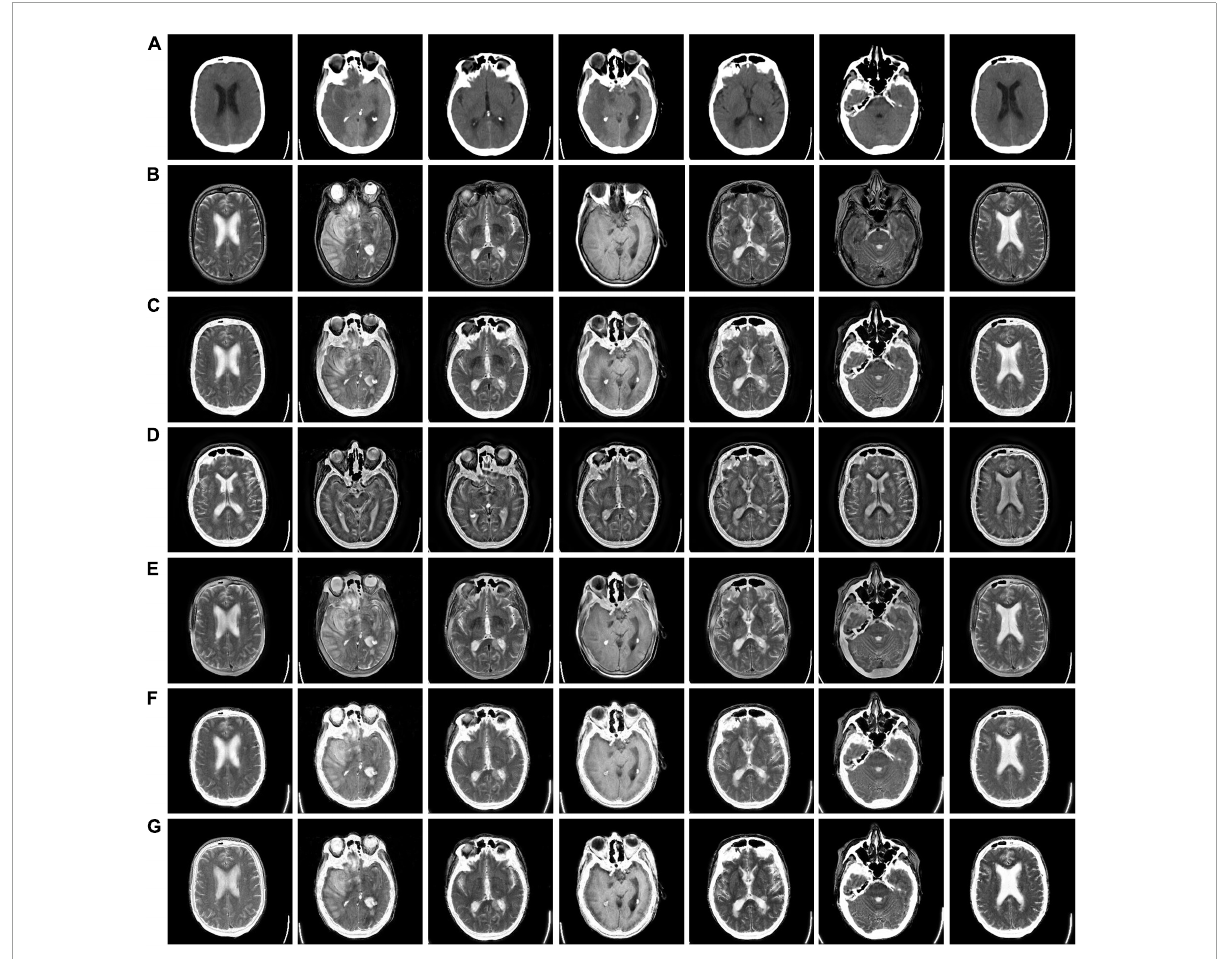
FIGURE3 CT-MRI fusion images obtained by five fusion methods. (A) Computed tomography (CT) source image; (B) magnetic resonance imaging (MRI) source image; (C) nonsubsampled contourlet (NSCT) fusion result; (D) non-subsampled shear wave transform (NSST) fusion result; (E) guided filter ng fusion (GFF) fusion result; (F) Laplacian redecomposition (ReLP) fusion result; (G) fusion result of the proposed